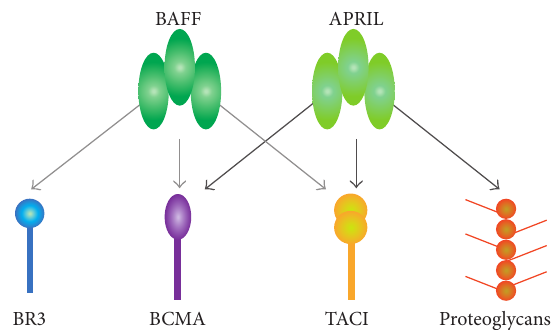
Figure 7: BAFF and APRIL receptors. BAFF binds chiefly to BAFF- R (BR3) but also to BCMA and TACI. APRIL, in turn, interacts with TACI and BCMA, but not with BR3. In addition, APRIL binds to proteoglycans expressed in membranes of lymphoid and nonlymphoid